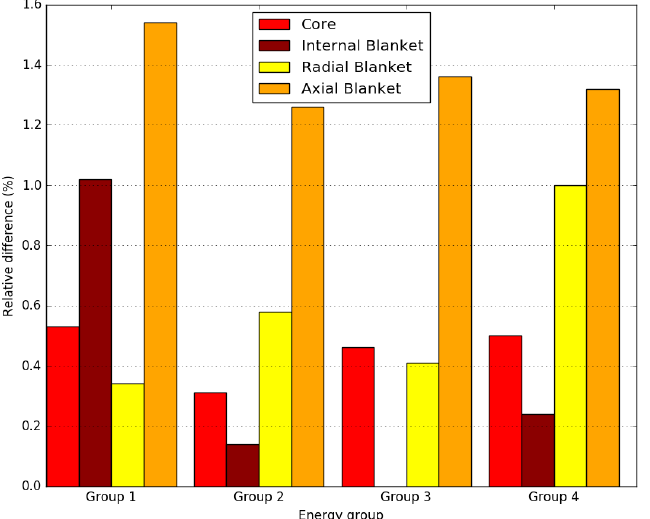
Figure 19. Comparison of region-averaged flux from reference and AZTRAN Model 3 Case 2.